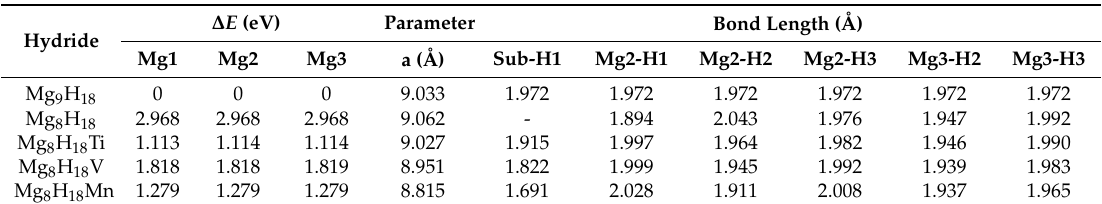
Table 2. The energy ( ∆ E ), the lattice parameter ( a ), and bond length of Mg 9 H 18 , Mg 8 H 18 and Mg 8 H 18 X (X = Ti, V, and